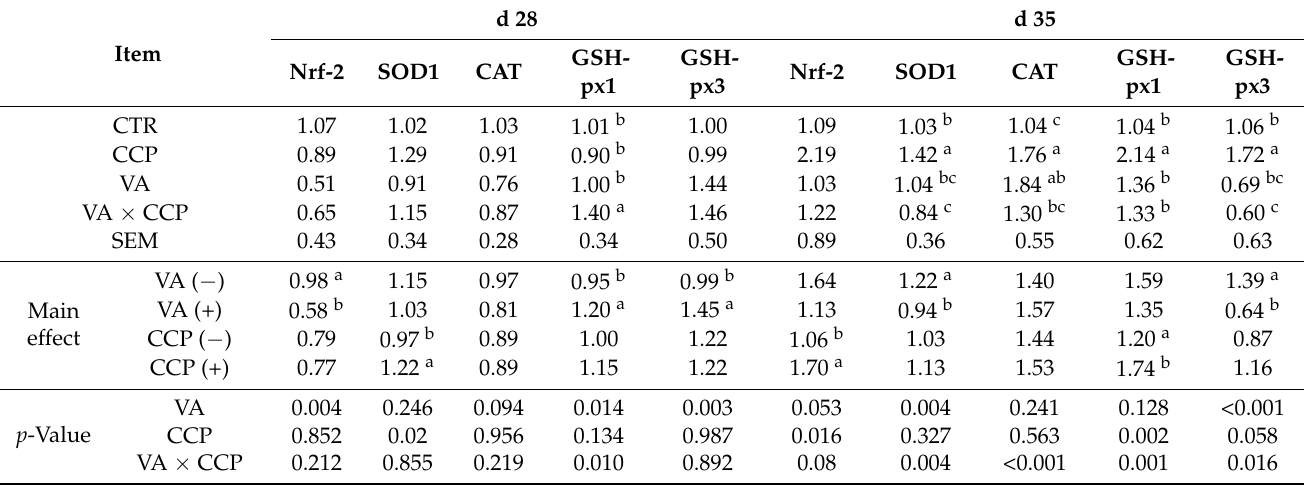
Table 8. Effect of vitamin A on mRNA levels of antioxidant-related genes in the jejunum of CCP- challenged broilers.